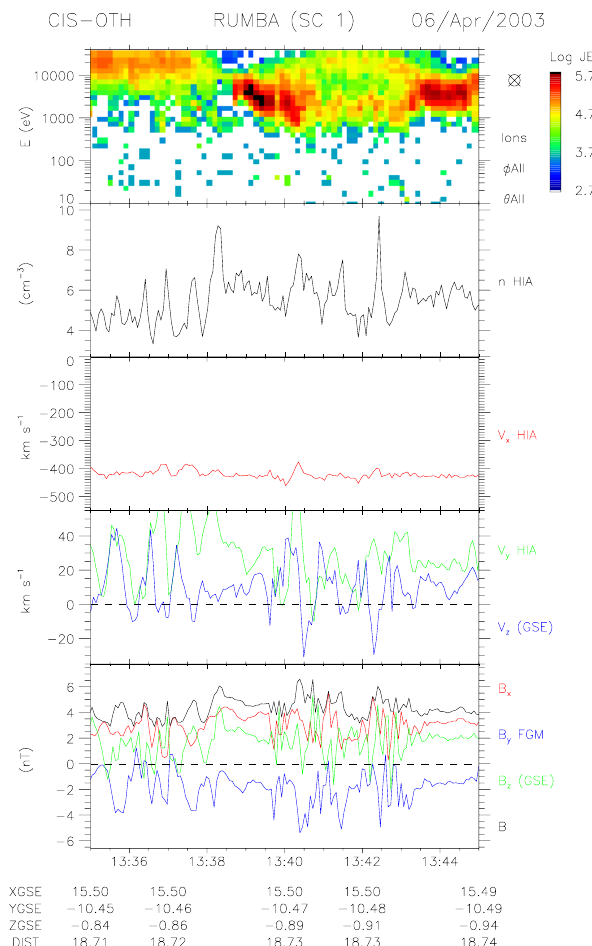
Fig. 3. Cluster-CIS and FGM observations for 27 January 2003. The format is the same as Fig. 1.